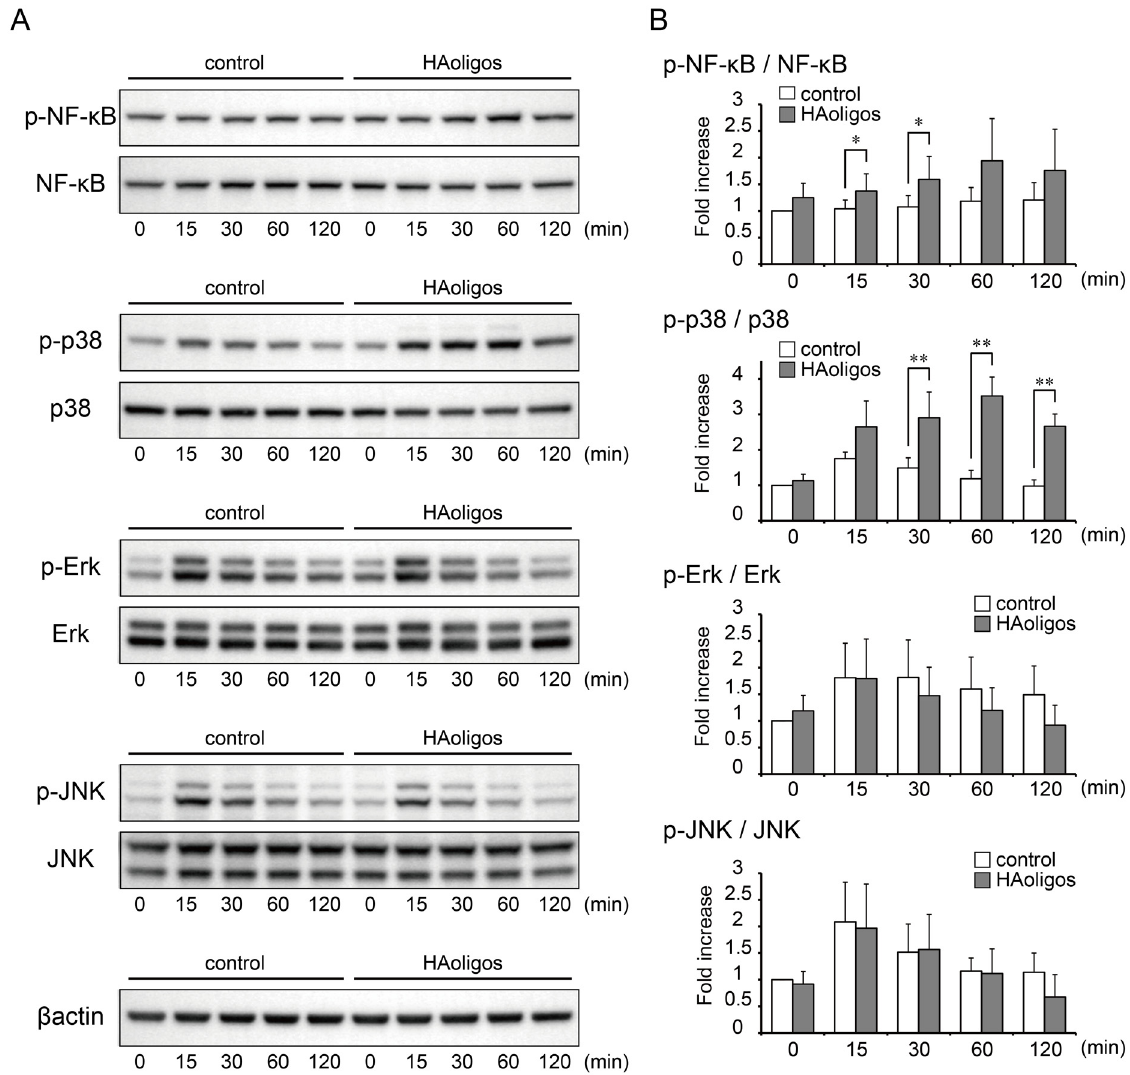
Fig 4. Intracellular signaling cascades stimulated by HAoligos with pre- and co-incubation with a TLR4 neutralizing antibody. RSFs were pre-treated for one hour with an anti-TLR4 antibody, followed by HAoligo treatment (250 μ g/ml). Phosphate buffered saline was substituted as a control. A , Phospho-nuclear factor κ B (NF- κ B), NF- κ B, phospho-p38 mitogen-activated protein kinase (MAPK), p38 MAPK, phospho-Erk, Erk, phospho-c-Jun N-terminal kinase (JNK), and JNK, as evaluated by immunoblot analysis of RSFs derived from three patients with RA. Results shown are representative of three experiments with similar results. B , Densitometry of phospho-NF- κ B/NF- κ B, phospho-p38 MAPK/p38 MAPK, phospho-ERK/ERK and phospho- JNK/JNK. Values are mean ± S.D. of three independent experiments and expressed as n-fold increase compared to untreated control at time 0. * p < 0.05 and ** p < 0.01 vs.